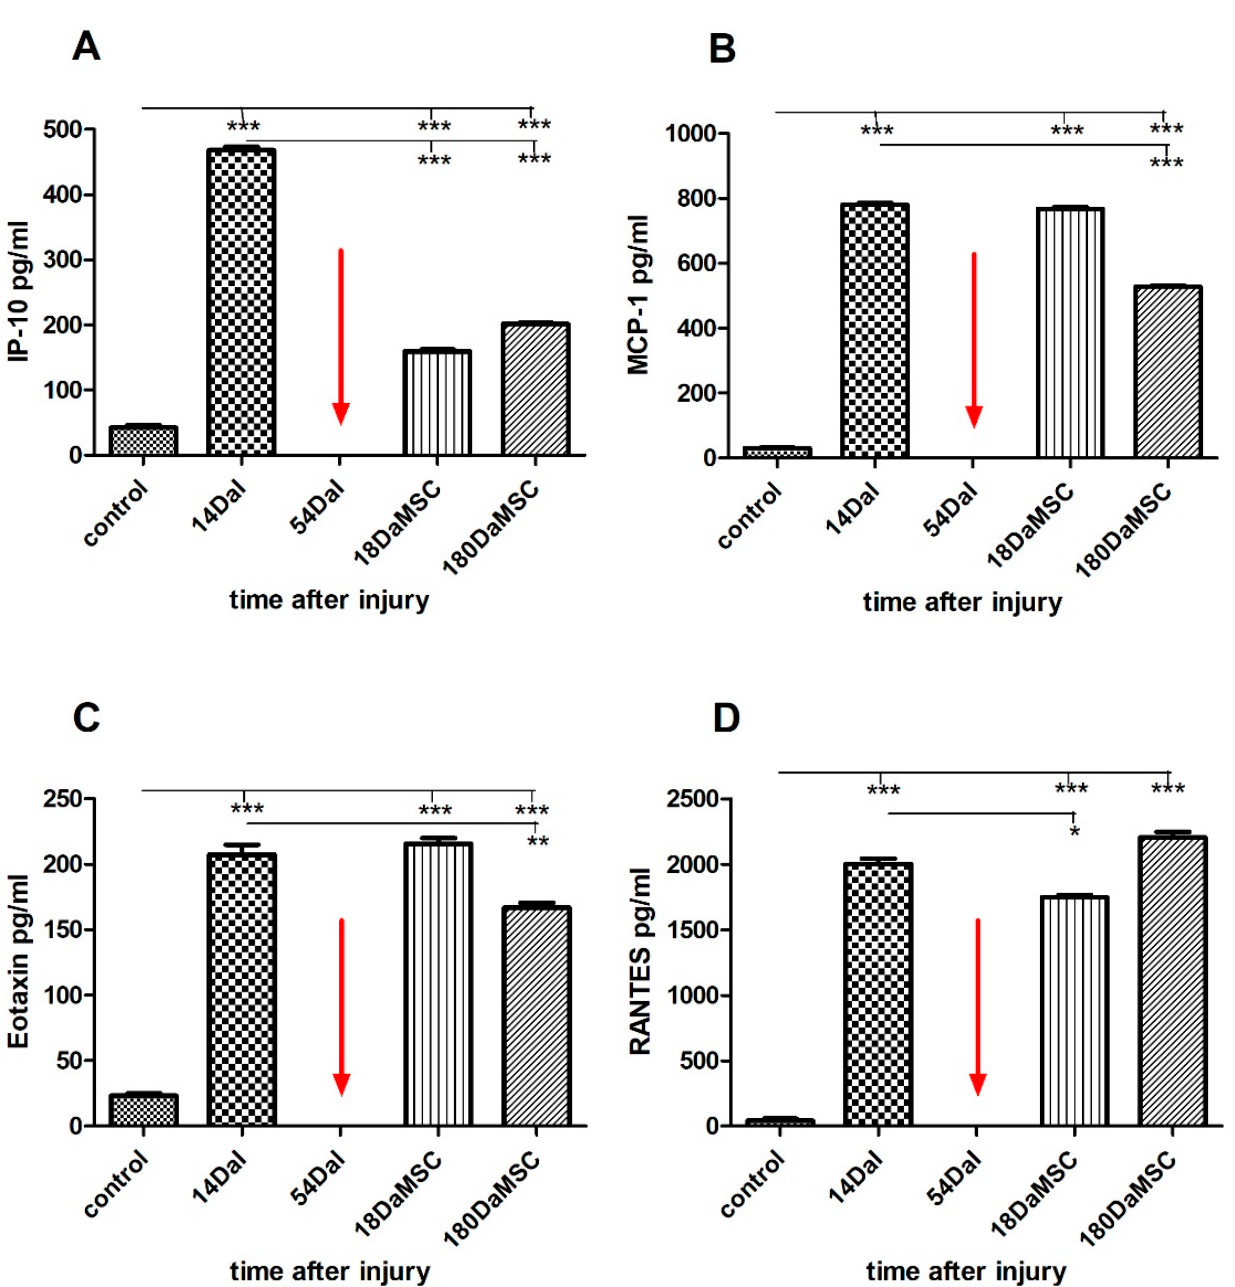
Figure 6. An overview of the level of the chemokine proteins in the serum of an SCI patient treated with autologous BM-MSCs. SCI caused a significant increase in IP-10 ( A ), MCP-1 ( B ), Eotaxin ( C ), and RANTES ( D ) protein levels in the patient’s serum at 14 DaI in comparison with controls. Ad- ministration of autologous BM-MSCs at day 54 post-injury resulted in a significant decrease in the levels of IP-10 and RANTES proteins at 18 DaMSC ( A , D ). The red arrow indicates the administration time of autologous BM-MSCs. Data are shown as the mean ± SD, * p < 0.05, ** p < 0.01, *** p < 0.001. DaI—Days after Injury, DaMSC—Days after BM-MSCs transplantation.